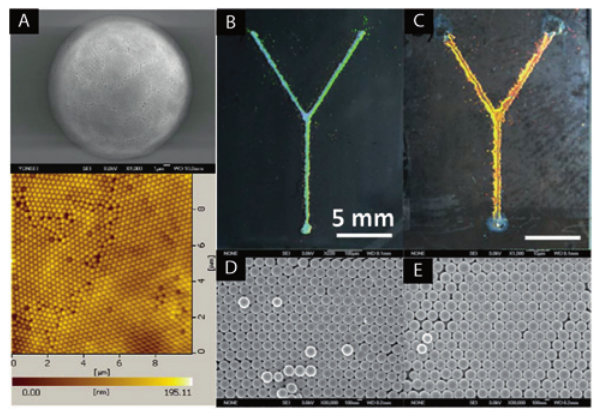
Figure 12: Photonic crystals formed using colloidal inks. (A) Photonic crystal droplet containing 190 nm polystyrene particles. ThetopimageistakenintheSEMwhilethebottomimageisobtained micro fl uidic channels written using multiple inks with different permission from Ref. [178]: (B – C) different micro fl uidic Y-channels written using different colloidal inks and exhibiting varied structural channels with 216 nm (D) and 235 nm (E) colloidal